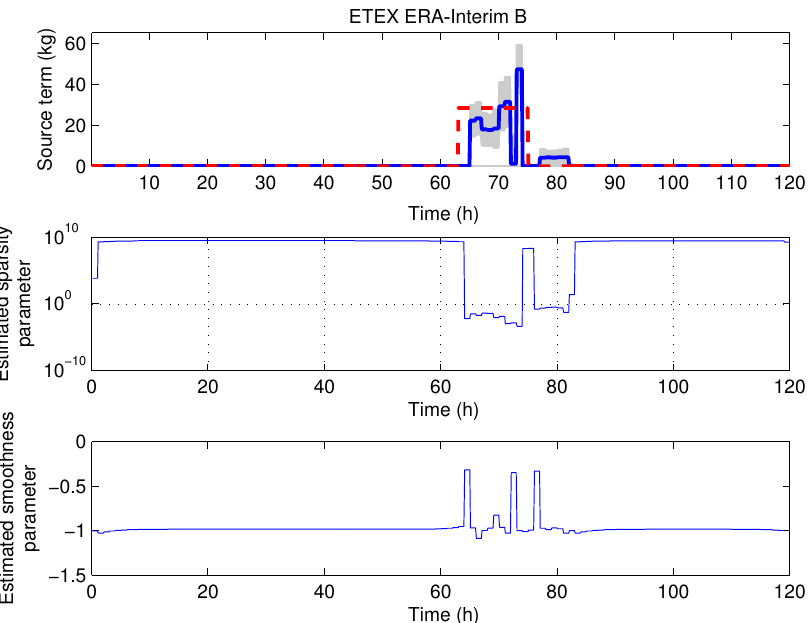
Figure 4. The results of the LS-APC algorithm for the ETEX experiment (ETEX ERA-Interim B). In the top panel, the true source term is given by the red line while the estimated source term is given by the blue line associated with the 99% highest posterior density region using gray filled regions. The estimated sparsity parameter, vector (cid:104) υ (cid:105) , is given in the middle panel and the estimated smoothness parameter, vector (cid:104) l (cid:105) , is given in the bottom